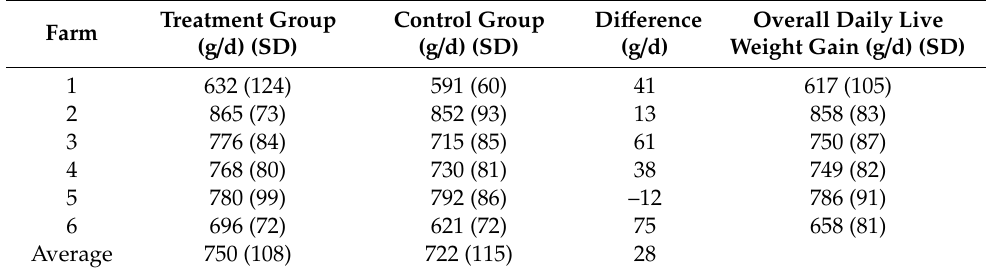
Table A4. Daily live weight gain di ff erences on each farm from one to 12 weeks old. Mathematical means are